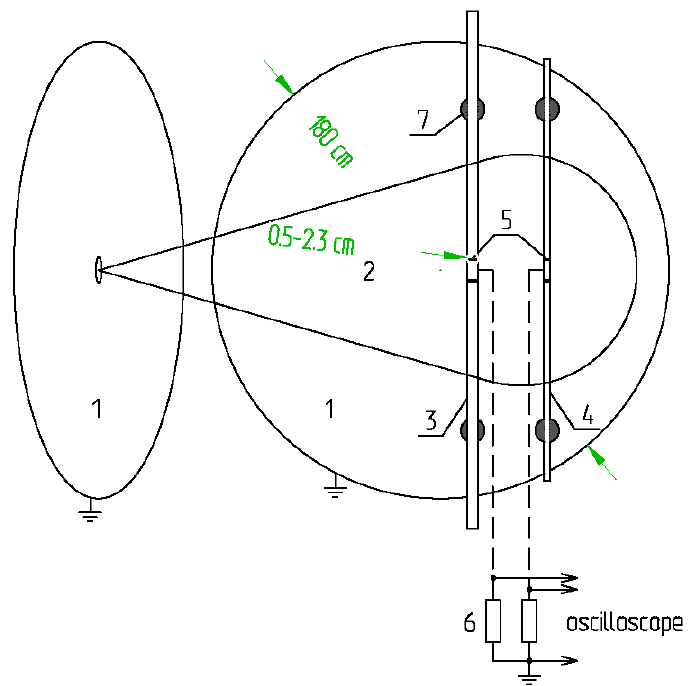
Figure 2. Second scheme of experimental and measurement setup: 1—grounded electrostatic screens; 2—artificial thunderstorm cell; 3,4—cylinder electrodes; 5—isolated elongated elements; 6—shunts: 7—insulators.